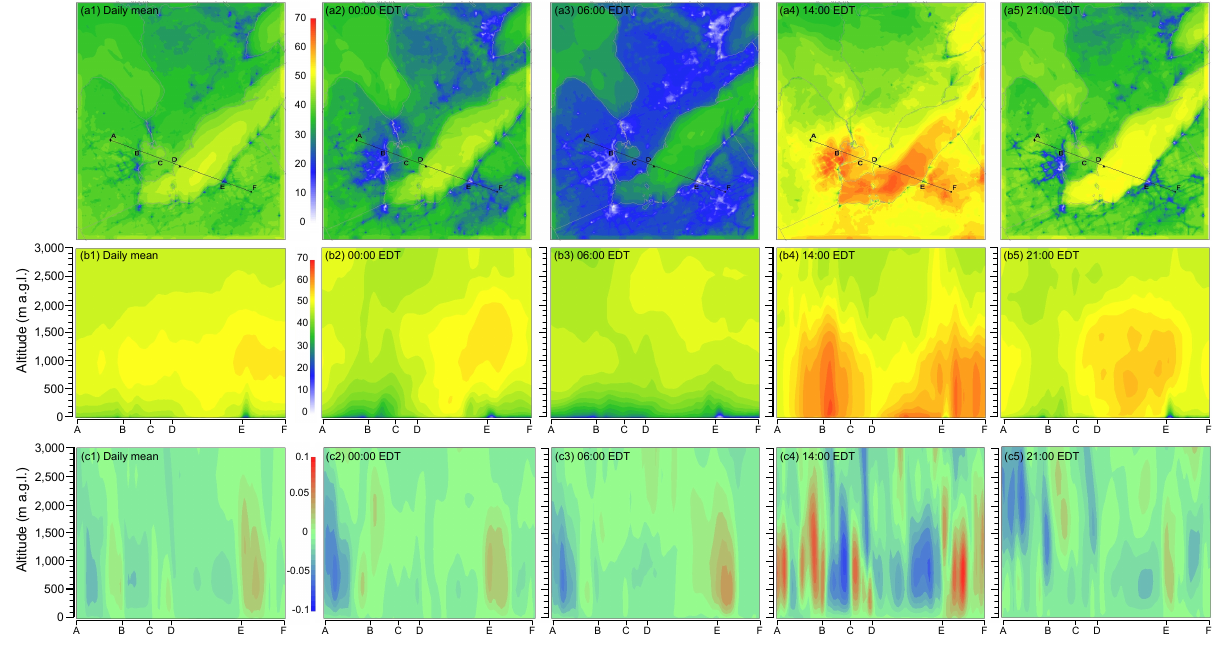
Fig. 4. Mean AURAMS model output showing (a) mean ground-level ozone, (b) mean ozone cross sections (ppbv), and (c) mean vertical velocity (ms − 1 ) for all 24h (a1, b1 and c1) and selected times (00:00, 06:00, 14:00 and 21:00EDT, a2-5, b2-5 and c2-5, respectively), calculated for the entire 23 days of the intensive campaign (18 June–10 July 2007). Cross sections are along transect A-F marked in (a), with contour intervals of 2ppbv for ozone and 0.01ms − 1 for vertical